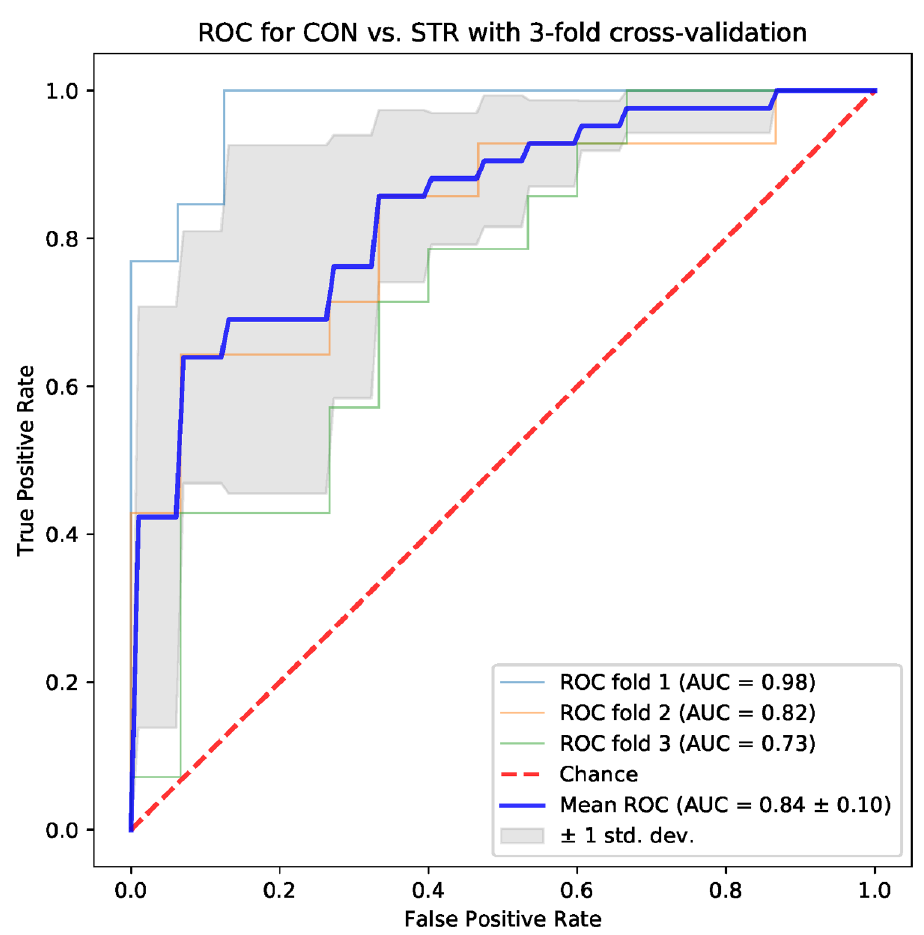
Fig 8. Results for the model trained with four topological parameters: Triangle location, number of intervals, length sum, signal to noise